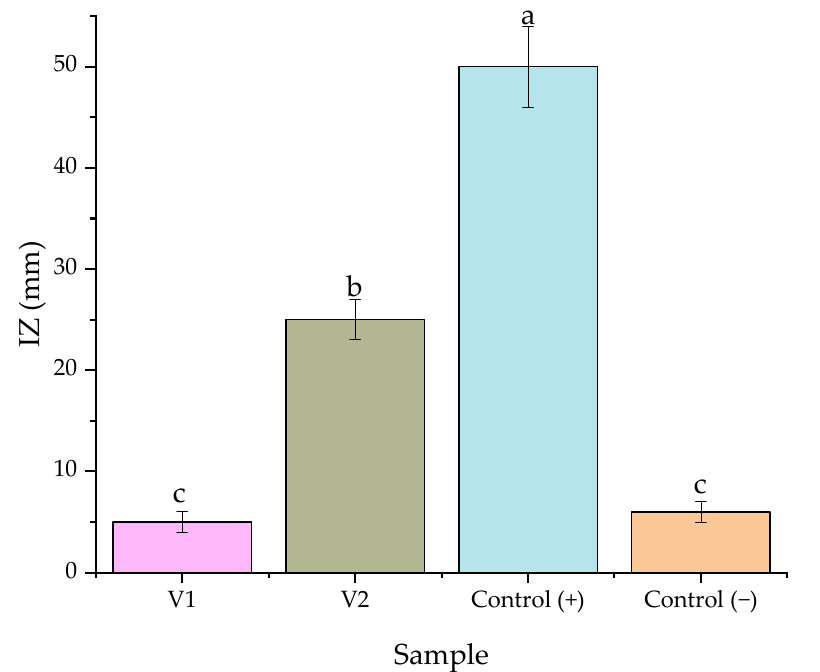
Figure 3. Antimicrobial potential of V1 and V2 samples against P. viticola in laboratory conditions. Control (+)—positive control (Pergado F 45 WG), Control (−)—negative control (hydroalcoholic solution). The values represent means ± SD. Means of the same parameter without a common lowercase letter (a to c) differ ( p < 0.05) as analyzed by one-way ANOVA and the TUKEY